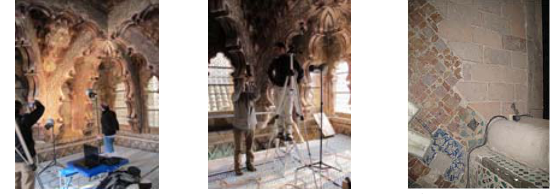
Figure 10. Taking Canon G10 photographs of the sides of the ribs and arches in the vault (left and middle), and oblique shot at the extreme south part of the floor (where vertical shots couldn’t be properly